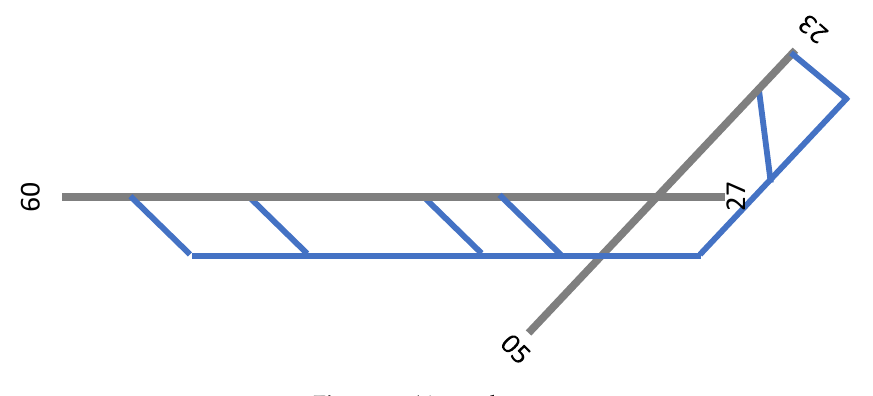
Figure 2. Airport layout.